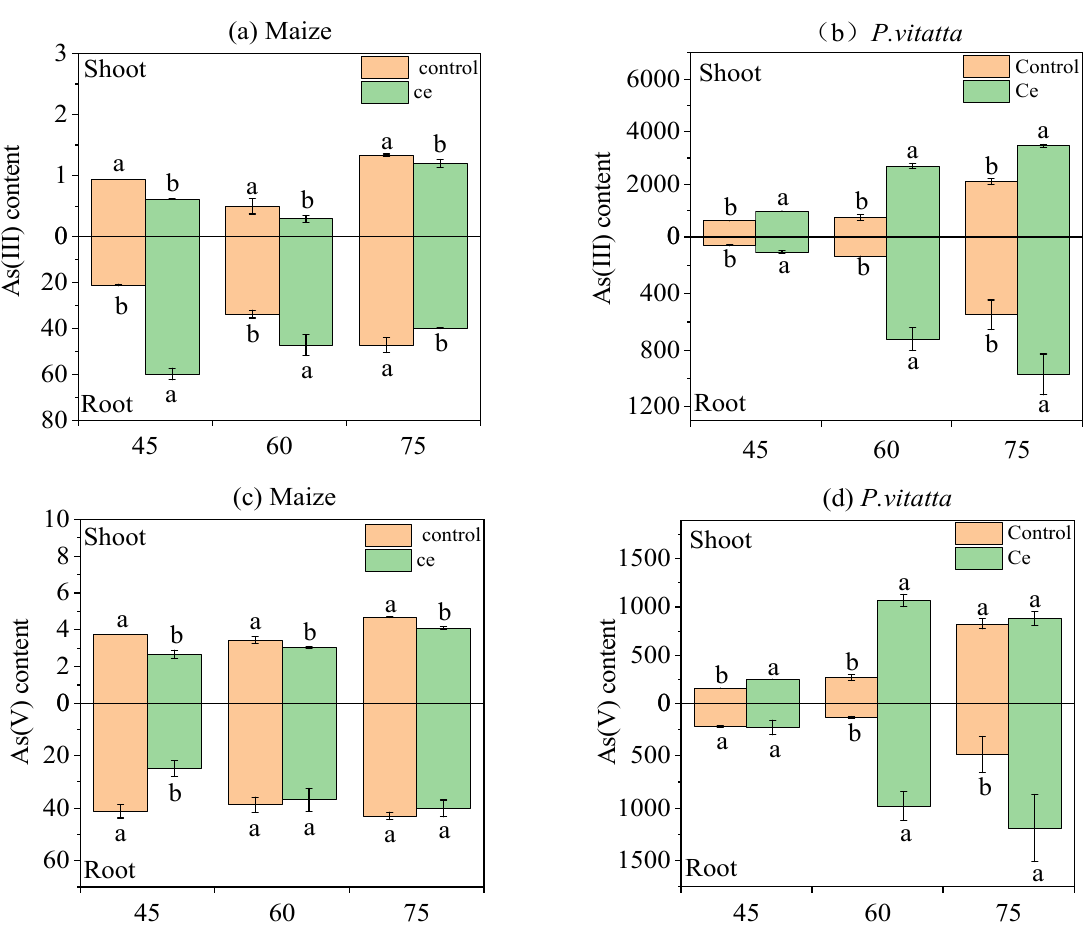
Figure 3. Effects of Ce colonization on the contents of As species in different parts of maize and P. vittata under As stress. As(III): ( a , b ); As(V): ( c , d ). As: arsenic; Ce, Claroideoglomus etunicatum . Lowercase letters “a” and “b” in the same group in the graph indicate significant differences between treatments ( p < 0.05).